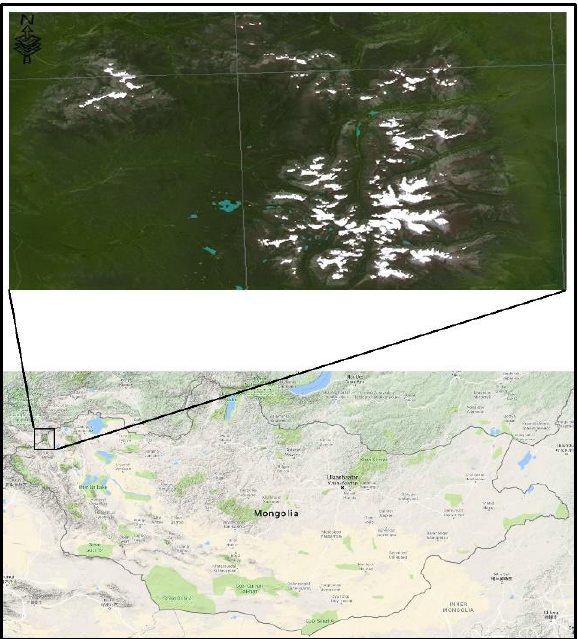
Figure 1. The Ikh Turgen mountain glacier in study area The study area of glacier is located between 89°8'7"E, 50°5'43"N (right top corner) and 90°0'7."E, 49°41'43"N (left bottom corner).